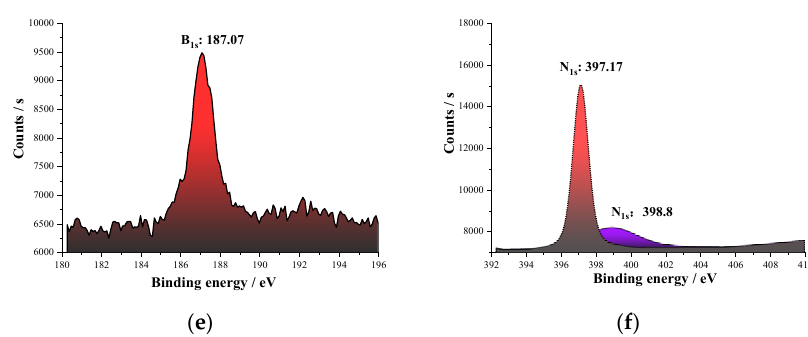
Figure 7. X-ray photoelectron spectroscopy (XPS) patterns: ( a , b ) Survey spectra scanning of the cBN powder and NicBN/Ti6Al4V composite coating; ( c , e ) high resolution spectral analysis of the B1s peak of the cBN powder and NicBN/Ti6Al4V composite coating; ( d , f ) high resolution spectral analysis of the N1s peak of the cBN powder and NicBN/Ti6Al4V composite coating.